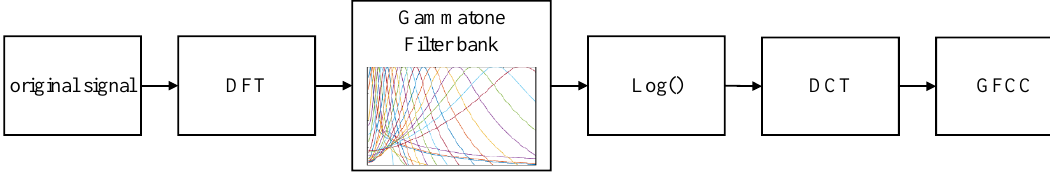
Figure 4. GFCC algorithm flow chart.